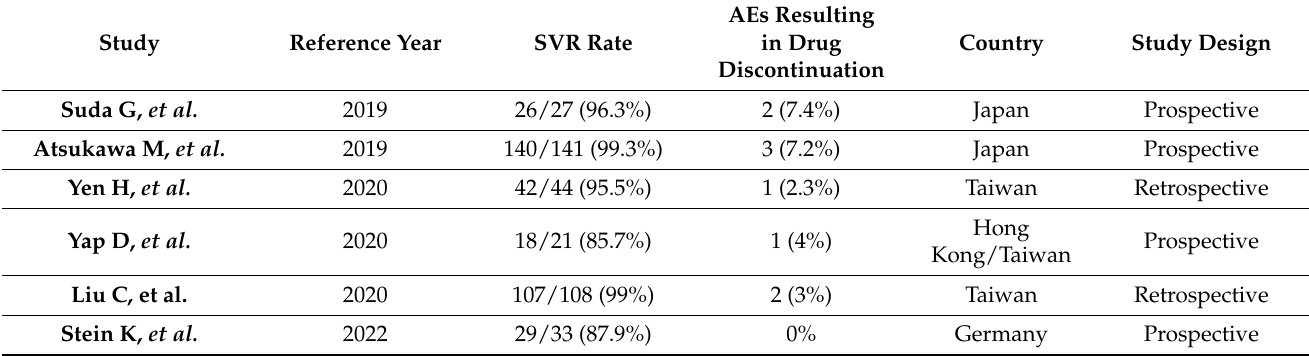
Table 2. Pan-genotypic agents (GLE/PIB) for HCV in advanced CKD: real-life